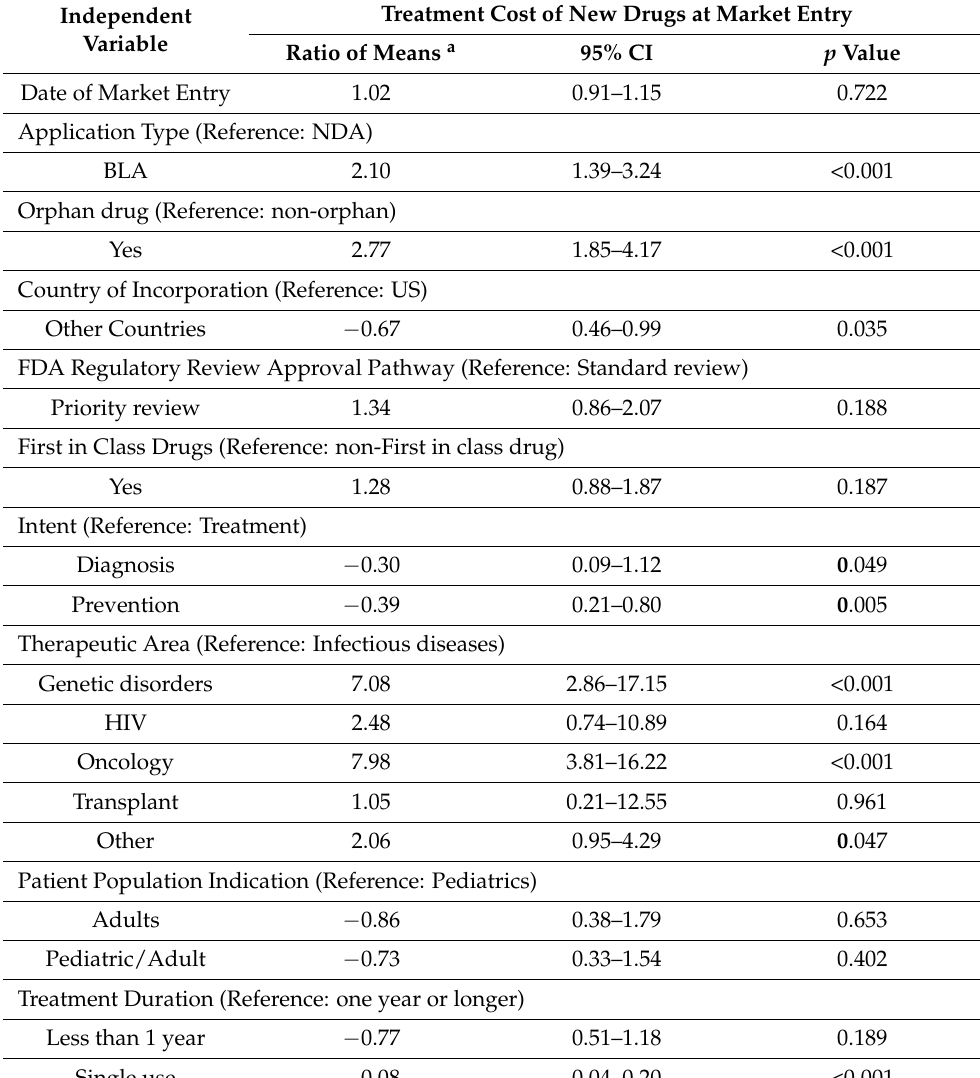
Table 2. Factors explaining the treatment cost of new drugs at market entry,